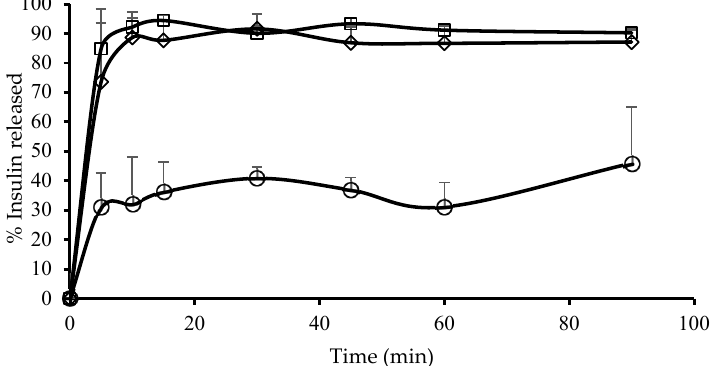
Figure 2. Dissolution curves displaying the percentage of insulin released as a function of time for the di ff erent microparticle formulations. ( ) E + AVP emulsion = microparticles prepared by emul- sion-solvent evaporation consisting of Eudragit ® L100 and A. vera polysaccharides, ( ) AVP emul- sion = microparticles prepared by emulsion-solvent evaporation consisting of A. vera polysaccha- rides and ( ) AVP ionic gelation = microparticles prepared by ionic gelation consisting of A. vera polysaccharides.